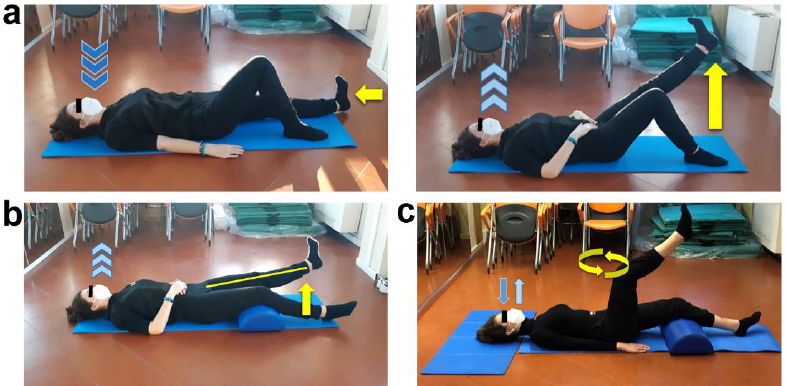
Figure 4. Quadriceps strengthening and hip rotation exercises in supine decubitus position. ( a ) Resting leg flexed and working one extended, arms laying by body sides with hand palms down. Inhale (dark blue arrows) while performing a dorsiflexion of working leg foot (horizontal yellow arrow), then exhale (light blue arrows) while lifting the extended leg upward (vertical yellow arrow) until knee reaches the height of contralateral one. Inhale and slowly get back to the starting position. Three sets of ten repetitions for each lower limb, 30 s of recovery. ( b ) Rest popliteal fossa of both legs on a semi-cylindrical cushion, bend arms and place hands on abdomen. Inhale, exhale (light blue arrows) while performing a leg extension (straight yellow line and vertical yellow arrow) with dorsiflexed foot. Keep this position for a few seconds, then inhale and slowly get back to the starting position. Three sets of one minute and a half for each lower limb, 30 s of recovery. ( c ) Arms laying by body sides with hand palms down, rest popliteal fossa of one leg on a semi-cylindrical cushion, flex and lift up the other leg until forming a 90° angle between thigh and trunk. Physiologically breathing (light and dark blue arrows), imagine drawing small circles by intra/extra rotating the lifted knee (curved yellow arrows). Three sets of 30 s for each lower limb, 30 s of recovery.